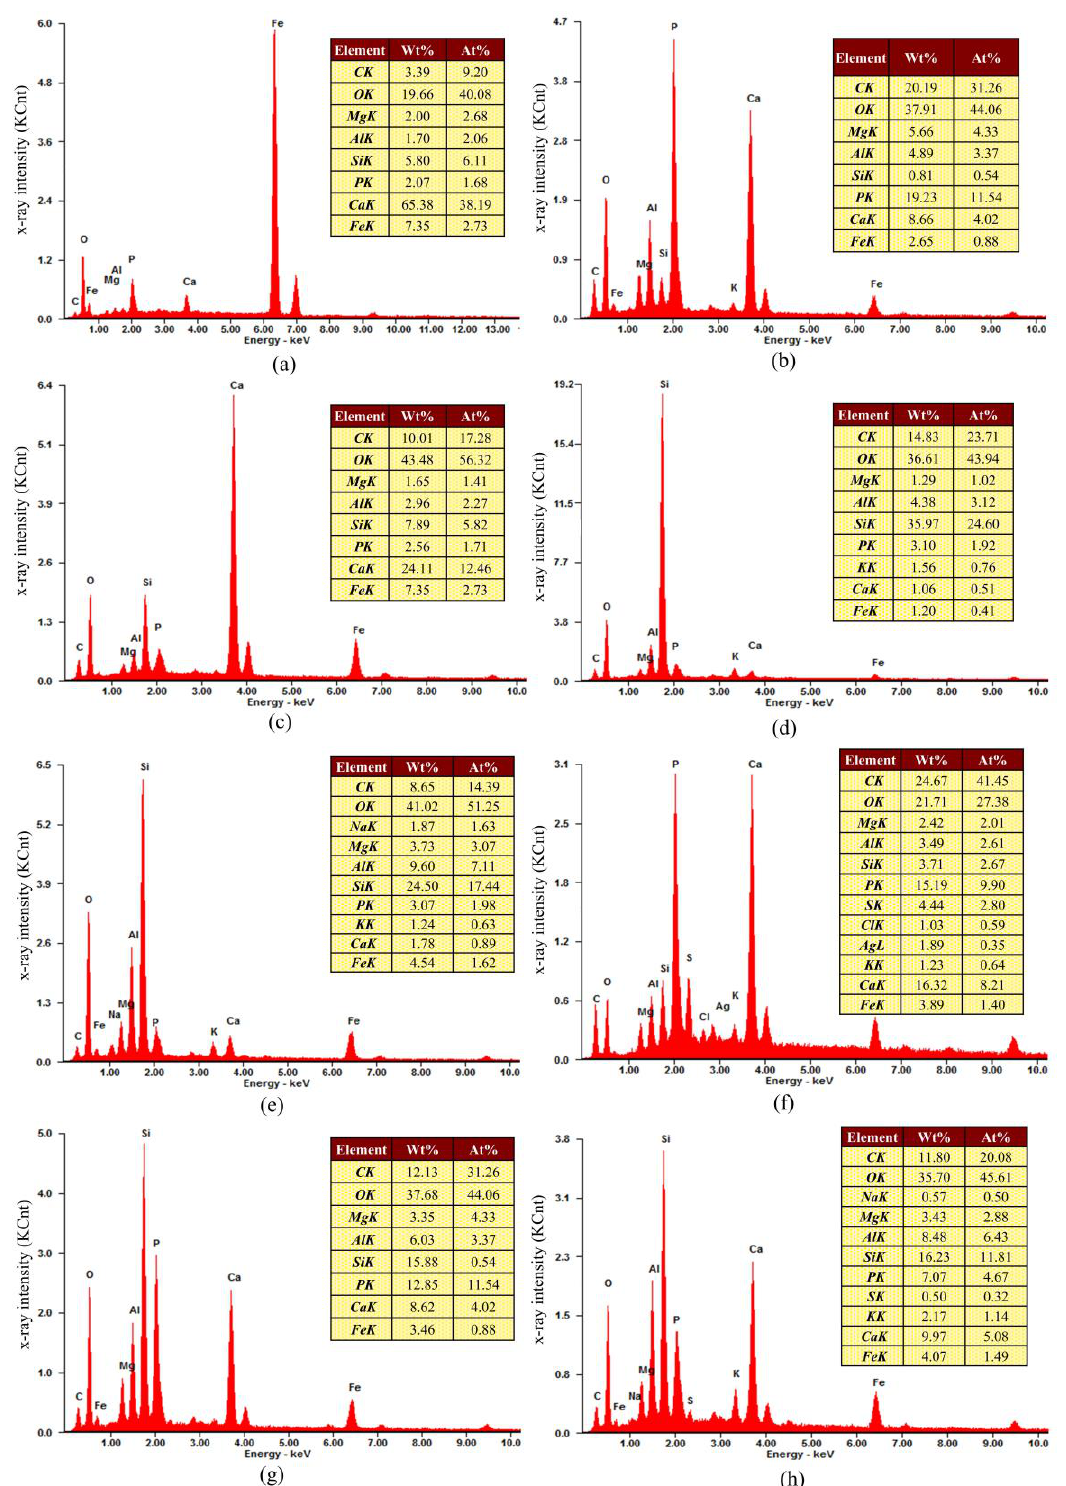
Figure 5. Energy spectrum analysis of chemical elements of clogging substances. Note: ( a , b ) — the clogging substances in filter screen; ( c , d ) — the clogging substances in filter core; ( e , f ) — the clogging substances in labyrinth emitters; ( g , h ) — the clogging substances in flat emitters. Energy represents the X-ray energy, the X-ray intensity, which is related to the number of elements, and the higher the atomic number, the higher the X-ray intensity, K = 1000, and Cnt is the quantity. Wt is the mass fraction and At is the atomic percentage.